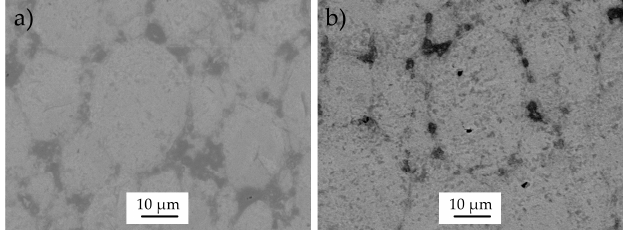
Figure 5. SEM images of TMCs made from starting powder with 5 vol % of amorphous B at 1000 °C for 15 min via ( a ) iHP; ( b ) dHP.